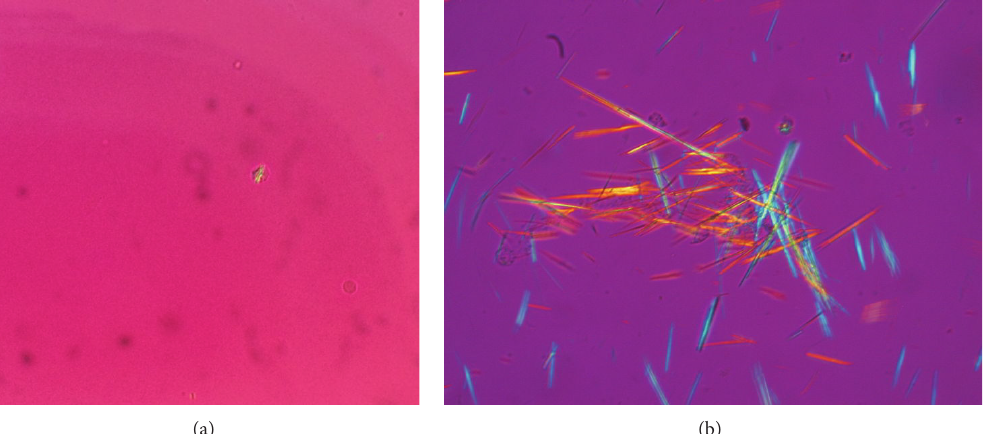
Figure 3: (From Wikipedia) Licensed under the Creative Commons Attribution-Share Alike 3.0 Unported license: (a) [12], (b)